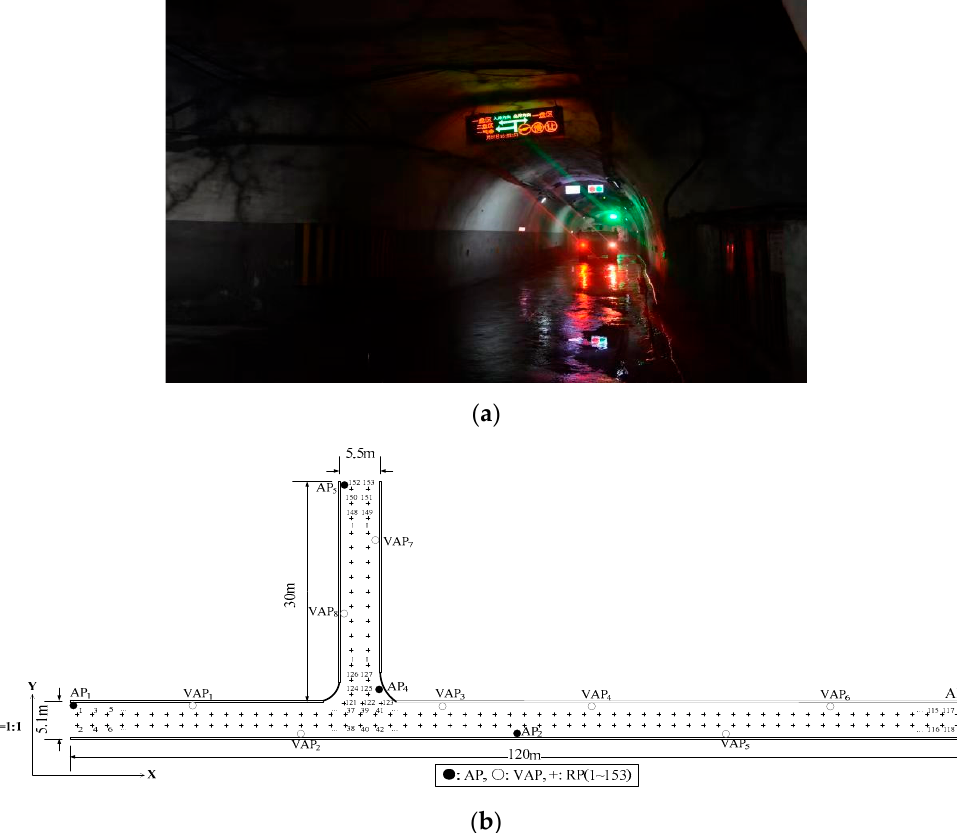
Figure 14. Diagram of experimental environment I: ( a ) Picture of the underground tunnel; ( b ) Plan of the underground tunnel.